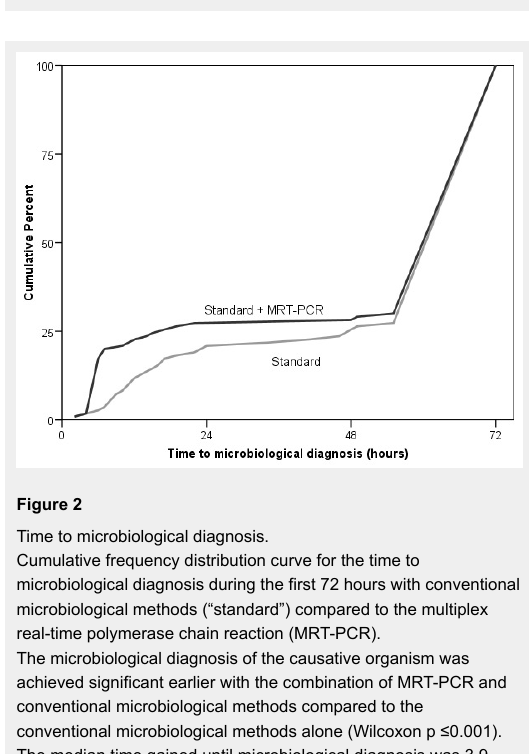
Time to positivity of the MRT-PCR and blood cultures. Time to positivity (TTP) of blood cultures (BC) in the 32 patients who were either positive with BC alone (PCR‒/BC+) or MRT-PCR alone (PCR+/BC‒) or positive with both BC and MRT-PCR (PCR+/ BC+). The 72 patients which were negative with both (PCR‒/BC‒) are not displayed. TTP of MRT-PCR is 6 hours by definition. The difference (Δ hours) between TTP of BC and MRT-PCR and the causative organism are displayed in each patient. For example, if the BC was positive after 24 hours and the MRT-PCR was positive (thus after 6 hours), the ΔTTP was 18 hours. If the microbiological method was negative or positive only after 72 hours, we used a cut-off of 72 hours to calculate the TTP.